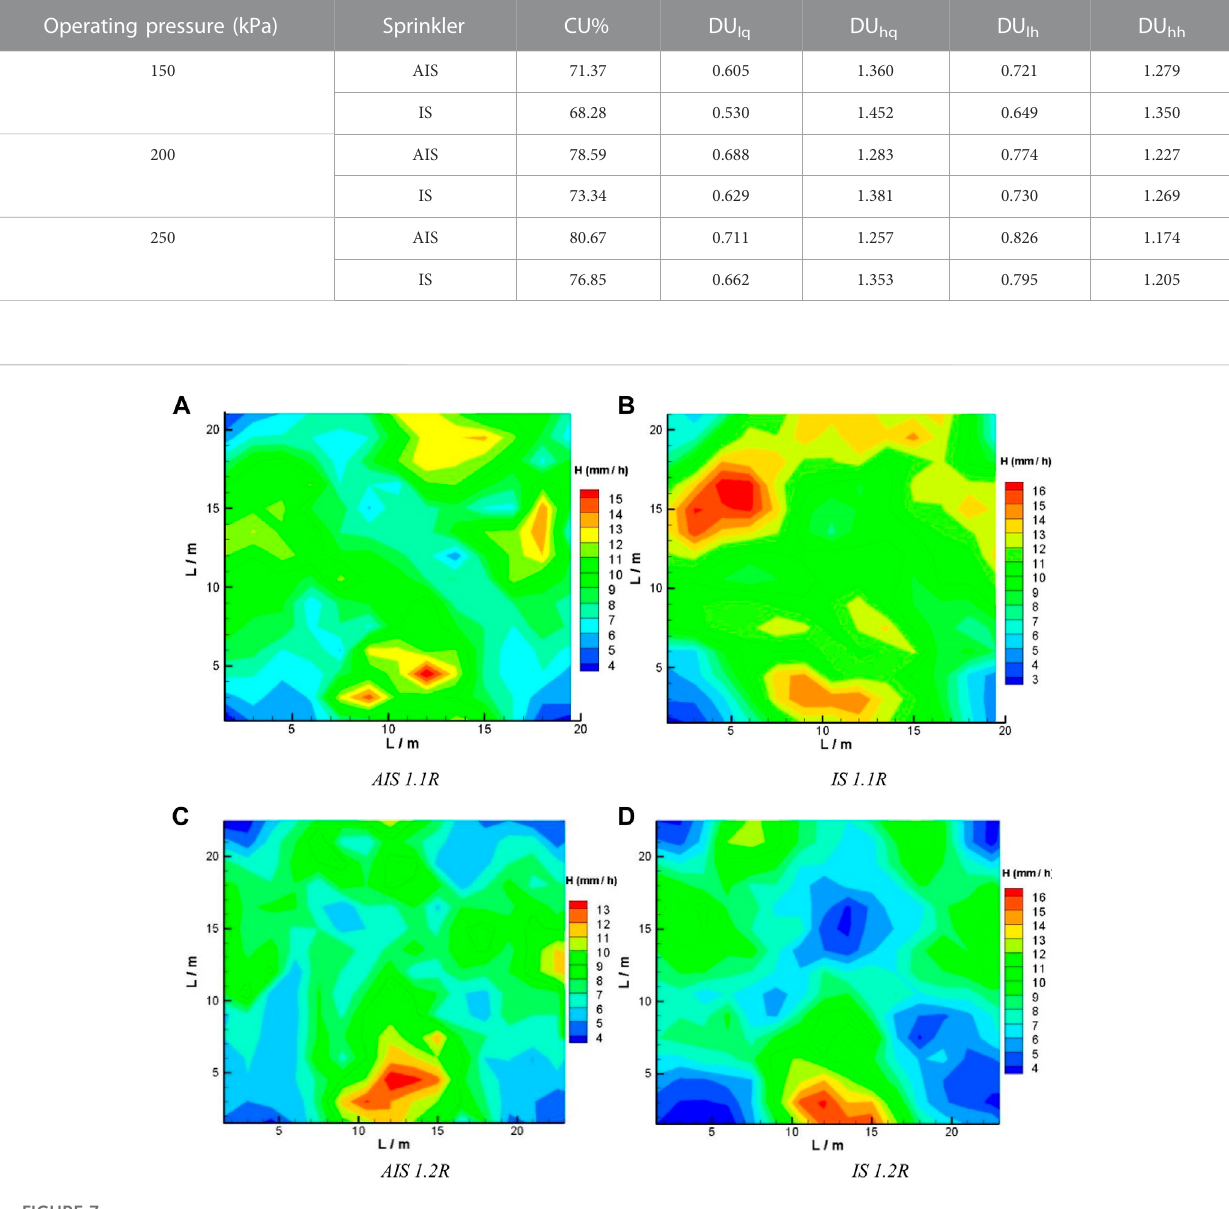
FIGURE 7 Contour map of the experimental data with an operating pressure of 250 kPa with different lateral spacing. AIS, aeration input sprinkler; IS, input sprinkler. (A) : AIS 1.1R (B) : IS 1.1R (C) : AIS 1.2R (D) : IS